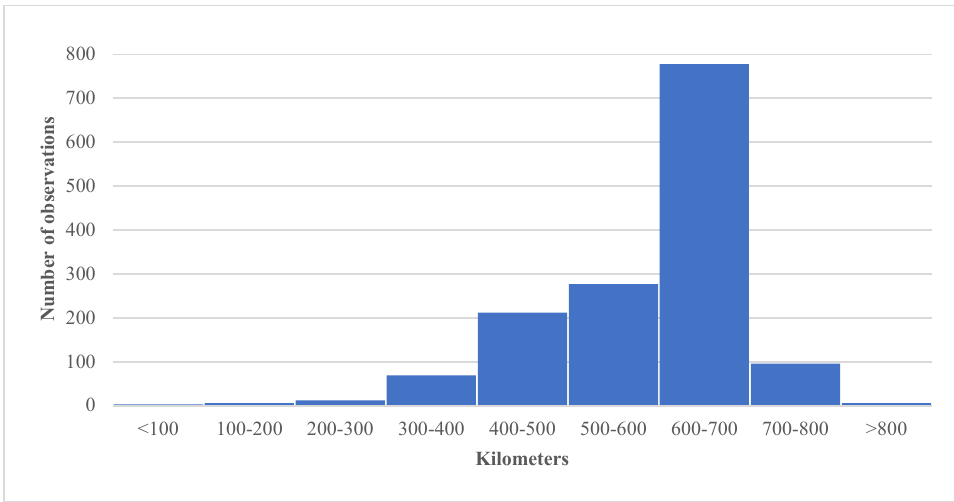
Figure 7. Car sample distribution by country. After studying the distribution of variables, an analysis was made of how the various variables influenced the continuous variable Mileage . Then, using the SPSS program, a linear regression was performed. According to the specifics of the problem at hand, it is